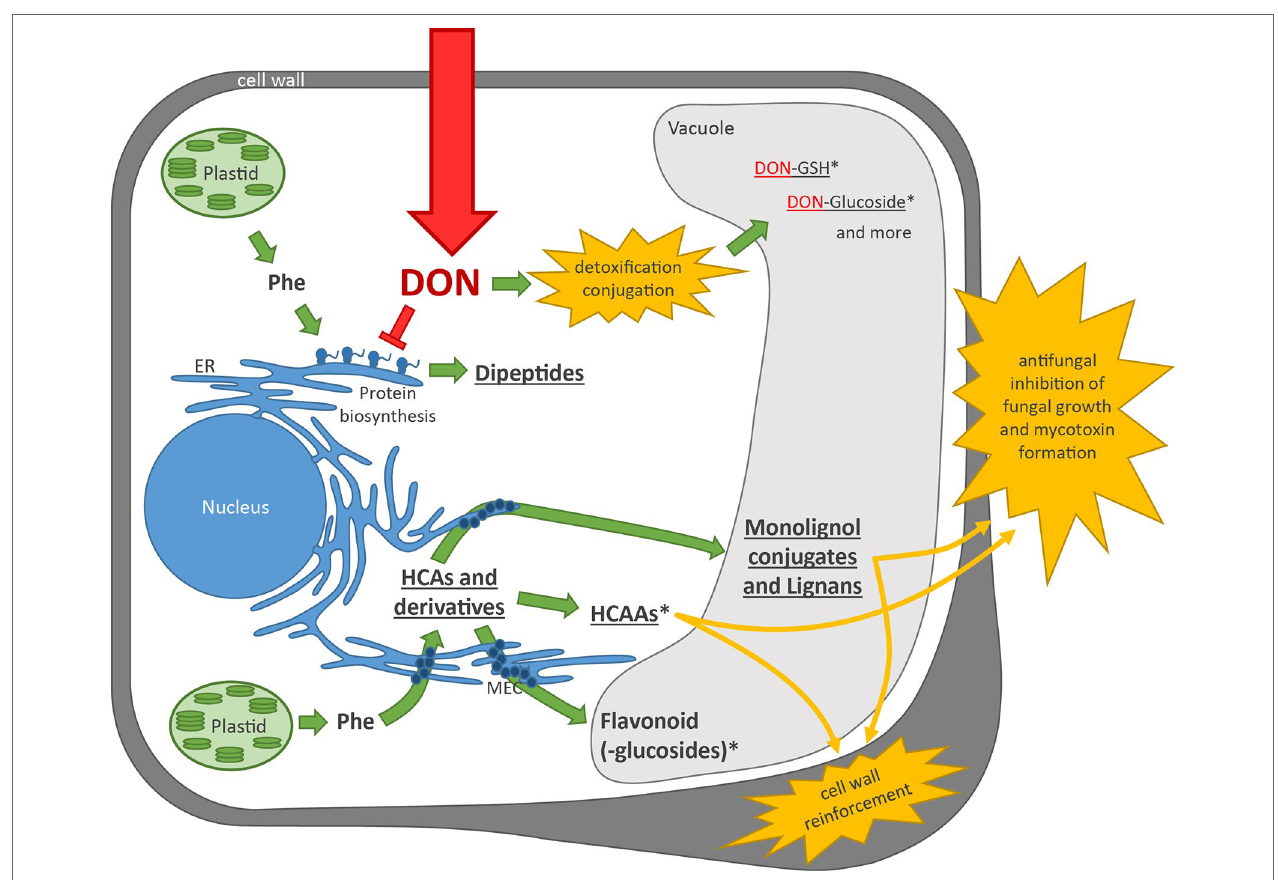
FIGURE 5 | Plant cell model showing the plants’ reaction on DON treatment. Green arrows indicate metabolic activity of the plant, and red indicates DON and its mode of action. Underlined metabolite (classes) indicate upregulation upon DON treatment observed in this experiment and in previous experiments (Kluger et al., 2015). *indicates an Fhb1 QTL effect. Yellow explosion: plant defense responses. DON, deoxynivalenol; Phe, phenylalanine; ER, endoplasmic reticulum; GSH, glutathione; HCA, hydroxycinnamic acid; HCAA, hydroxycinnamic acid amide; MEC, multienzyme